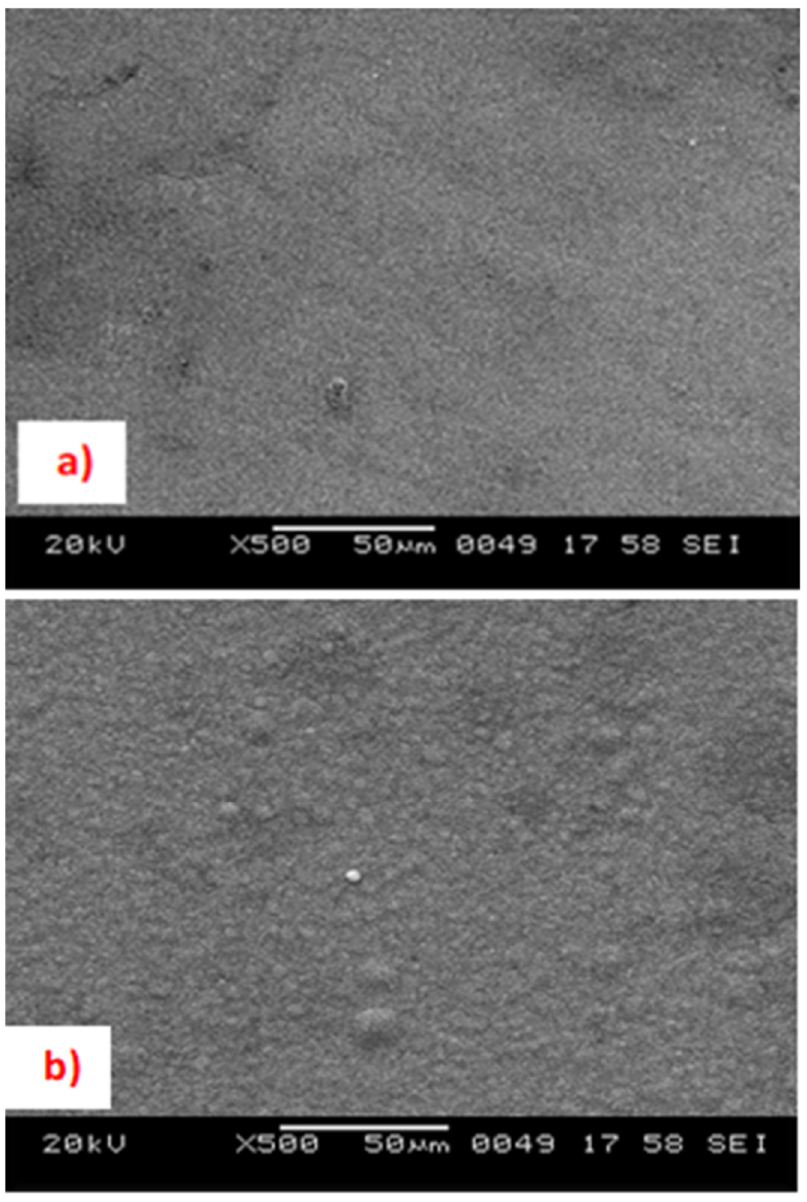
Figure 7. Surface topography of Zn-Fe multilayer coatings by the square ( a ) and triangular ( b ) current pulses.